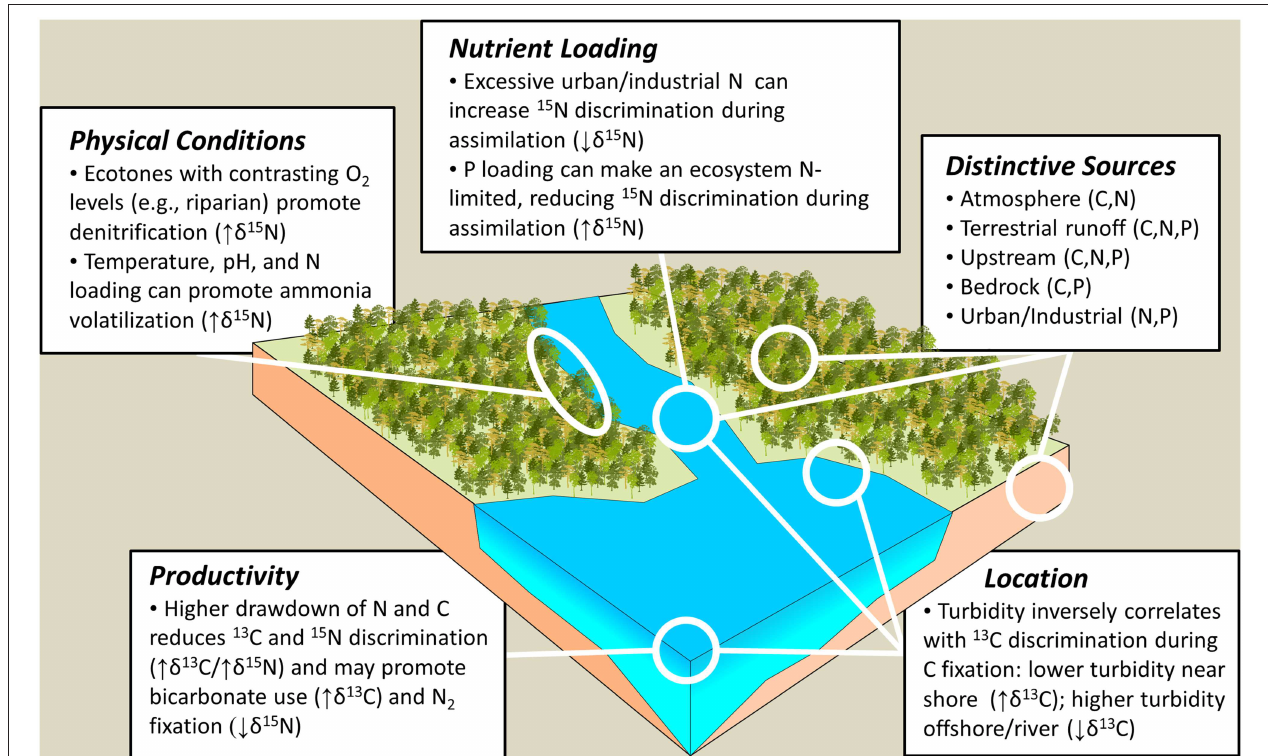
FIGURE 3 | Schematized landscape overview highlighting areas and processes where stable carbon and nitrogen isotope fractionations relevant to archaeological research